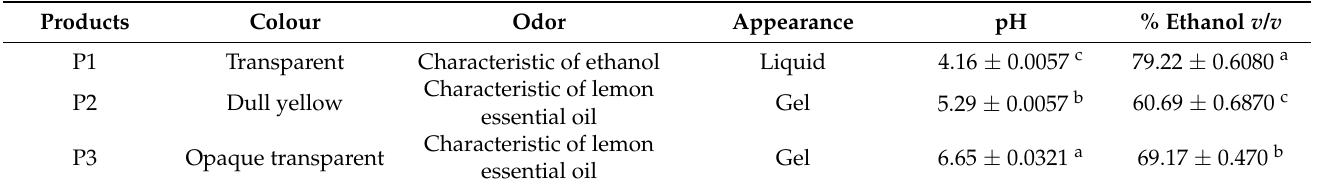
Table 1. The organoleptic properties and pH and alcohol strength by volume values of the three sanitizer products at T 0 . Every value was calculated as the mean ( ± SD) of three sample measurements ( n = 3). The different letters ( a , b , and c ) represent significant differences between the products ( p ≤